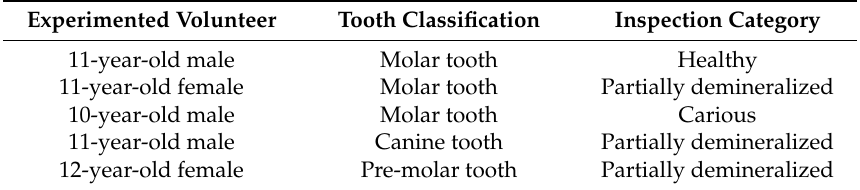
Table 2. The details of the experimented tooth